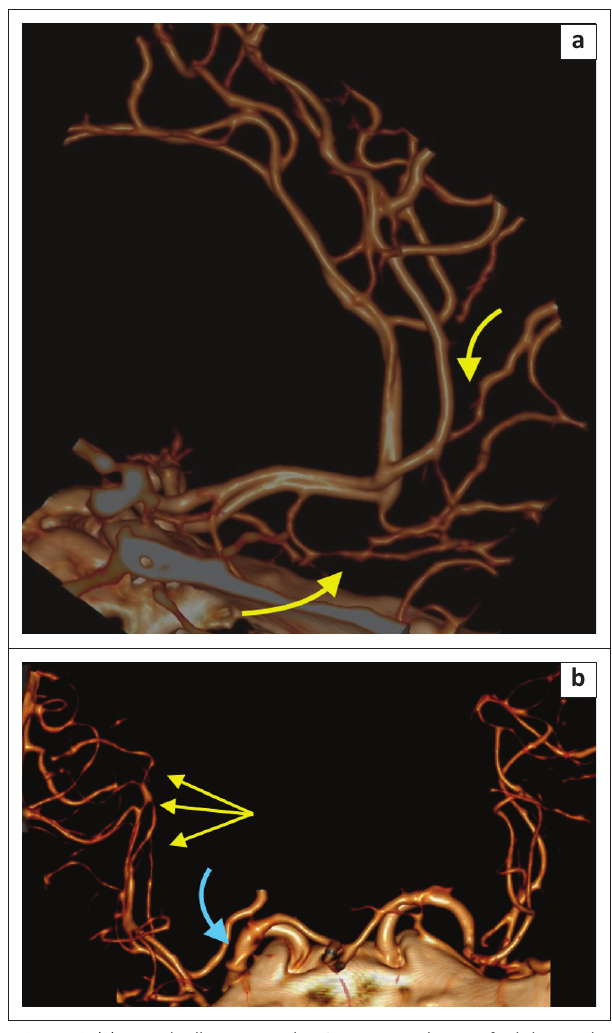
FIGURE 12: (a) Curved yellow arrows showing segmental areas of subtle vascular narrowing at the A3 branches of the anterior cerebral arteries; (b) Curved blue arrow demonstrating focal reduction in calibre of the right middle cerebral artery M1 segment. Straight yellow arrows showing sequential stenoses in the right middle cerebral arterial branches due to severe